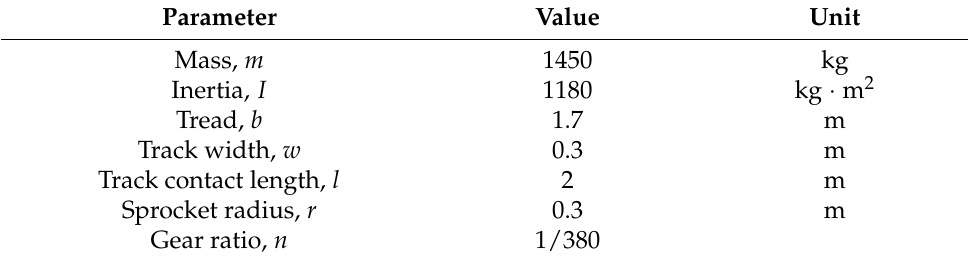
Table 1. Vehicle parameters.